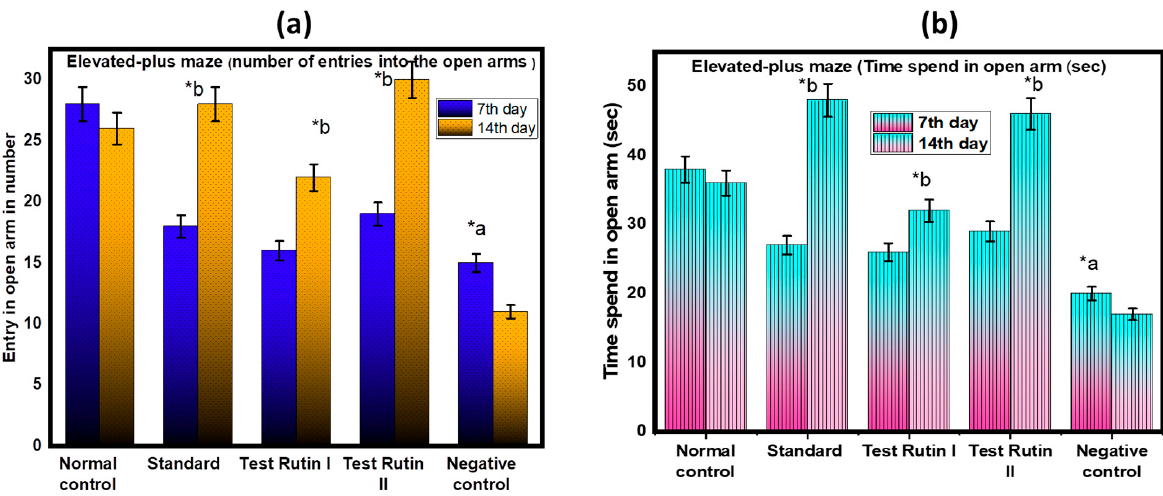
Figure 2. Effect of rutin pretreatment on antianxiety activity in rats using EPM: ( a ) EPM (number of entries into the open arms); ( b ) Time spend in open arm (sec). The results are expressed as mean ± SD values ( n = 6). The significance of the difference was determined by two-way ANOVA; * p < 0.05 vs. respective controls. a = normal control vs. reserpine control; b = reserpine control vs. test.